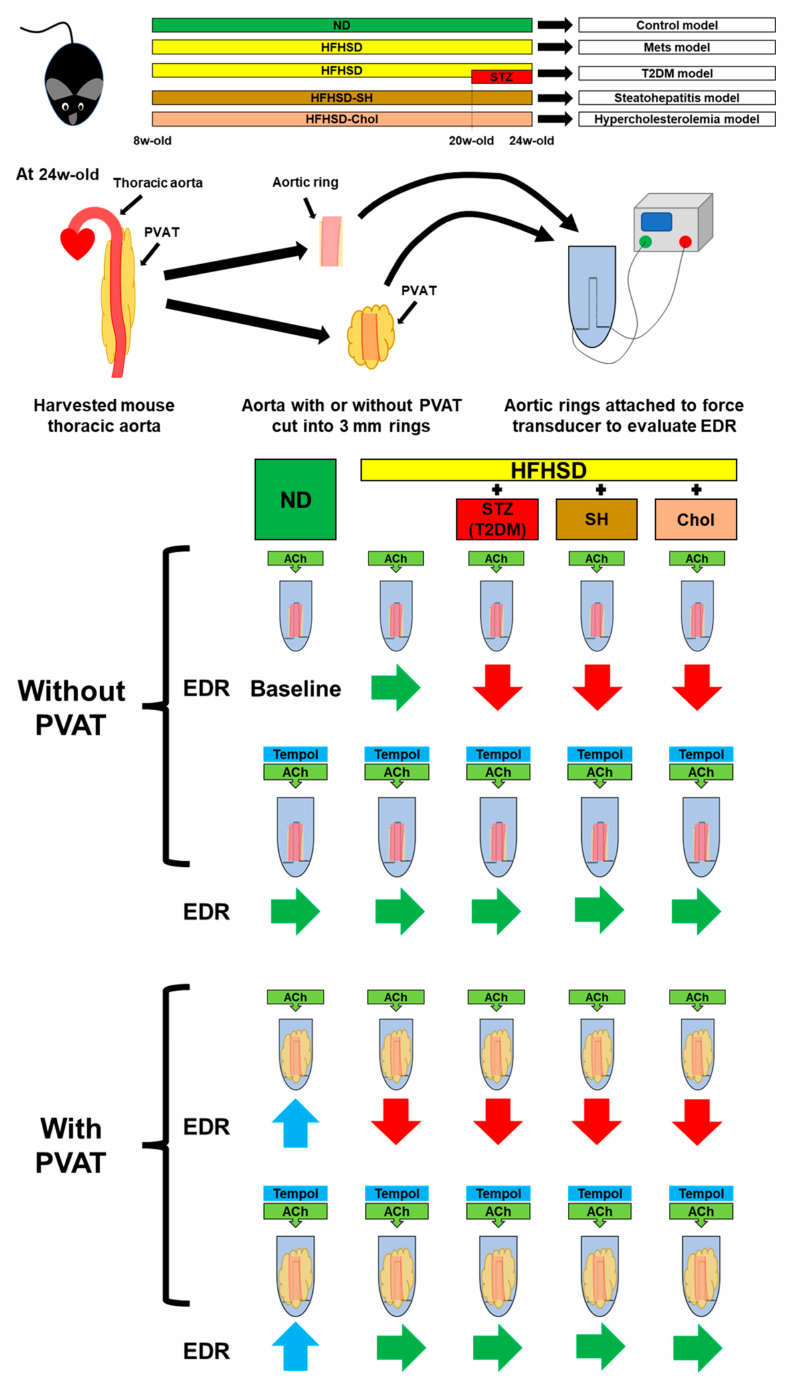
Figure 5. Summary of experimental results. ACh, acetylcholine; EDR, endothelium-dependent relaxation; PVAT, perivascular adipose tissue; STZ, streptozocin; T2DM, type 2 diabetes mellitus; ND, normal diet group; HFHSD, high-fat/high-sucrose (HFHSD) diet group; HFHSD-DM, HFHSD group that received STZ (50 mg/kg/day for 2 days at 20 weeks old); HFHSD-SH, choline-deficient HFHSD group; HFHSD-Chol, 1% cholesterol and 0.1% deoxycholic acid-containing HFHSD